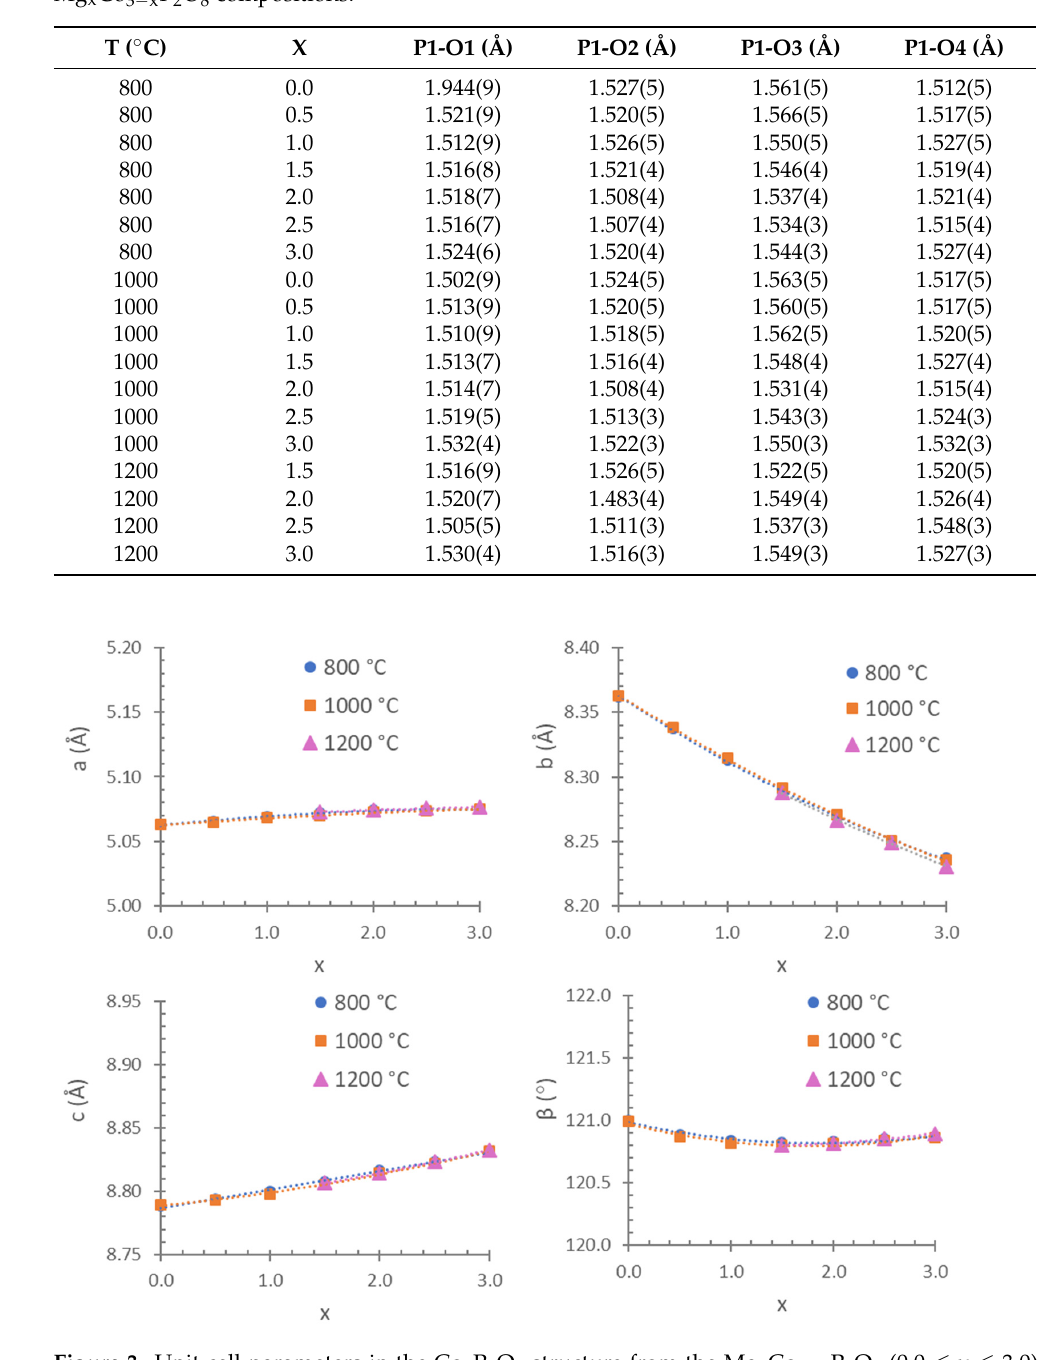
Table 4. Variations in the P-O distances in the stable Co 3 P 2 O 8 structure with temperature from the